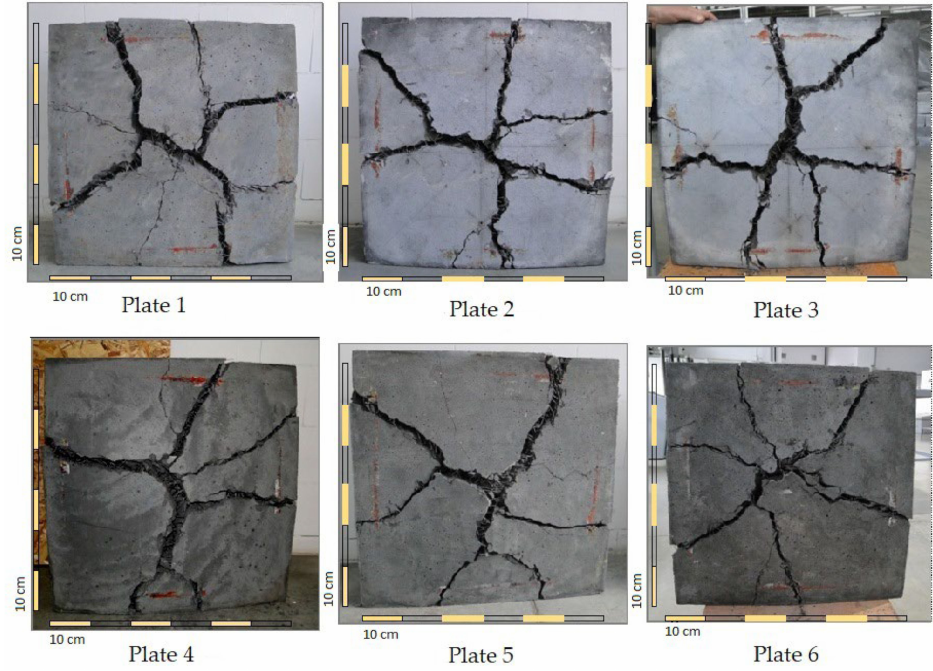
Figure 11. The images of the destruction of the plates made out of the fiber composite used in the study after the test of the energy absorption capacity.